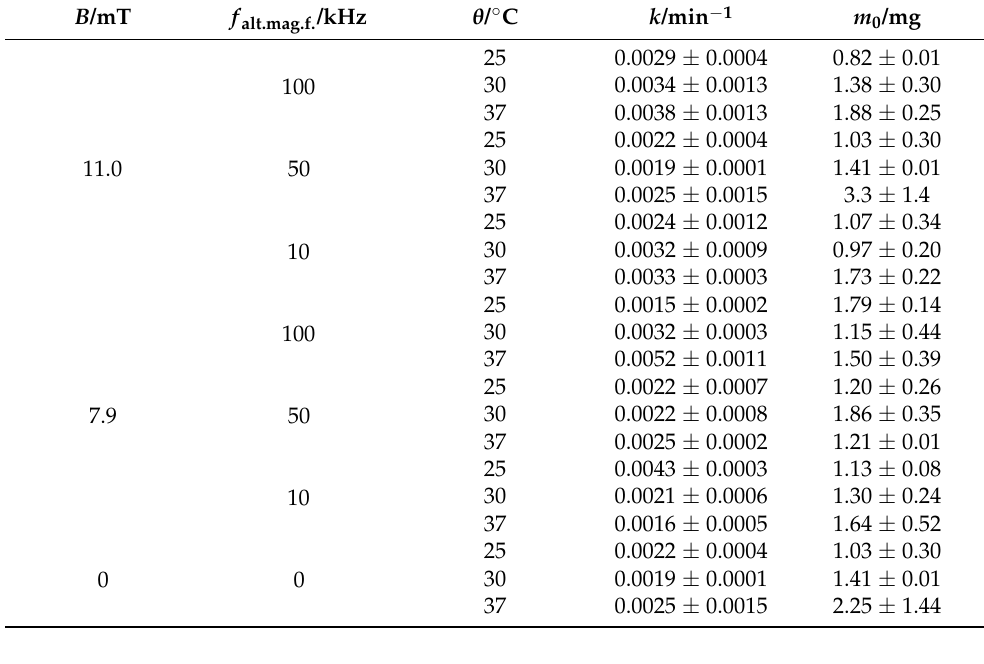
Table 2. The experimental release kinetics under the permanent magnetic fields of 7.9 mT and 11.0 mT and three frequencies (10 kHz, 50 kHz and 100 kHz) at temperatures 25 ◦ C, 30 ◦ C and 37 ◦ C.